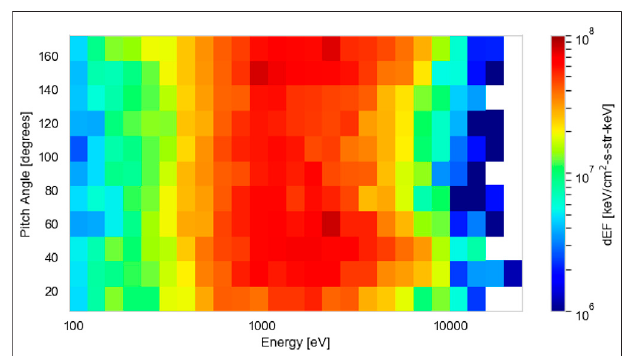
FIGURE2| Anexampletwo-dimensionalelectrondifferentialenergy fl ux distribution, as a function of pitch angle ( ° ) and energy (eV), measured by the Cluster-Plasma Electron and Current Experiment instrument in the magnetotail across a 4 s window (09:51:23 – 09:51:27 on October 13,